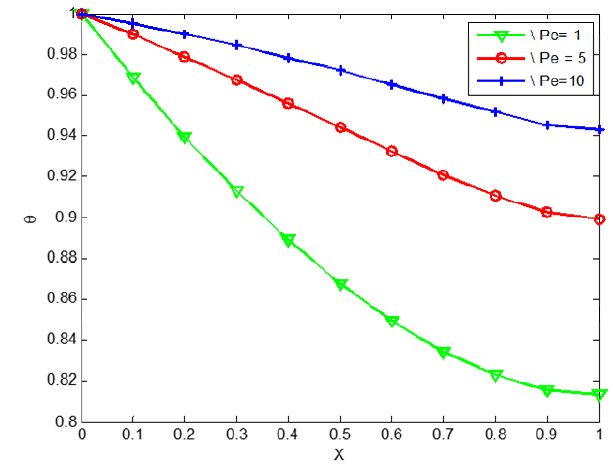
Figure 10. The effect of Peclet on the temperature distribution of a convex copper porous fins